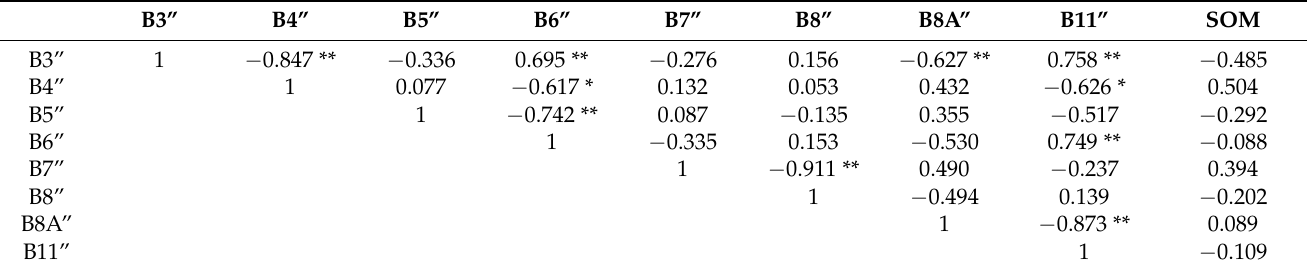
Table 5. The correlation between second-derivative image data and SOM.